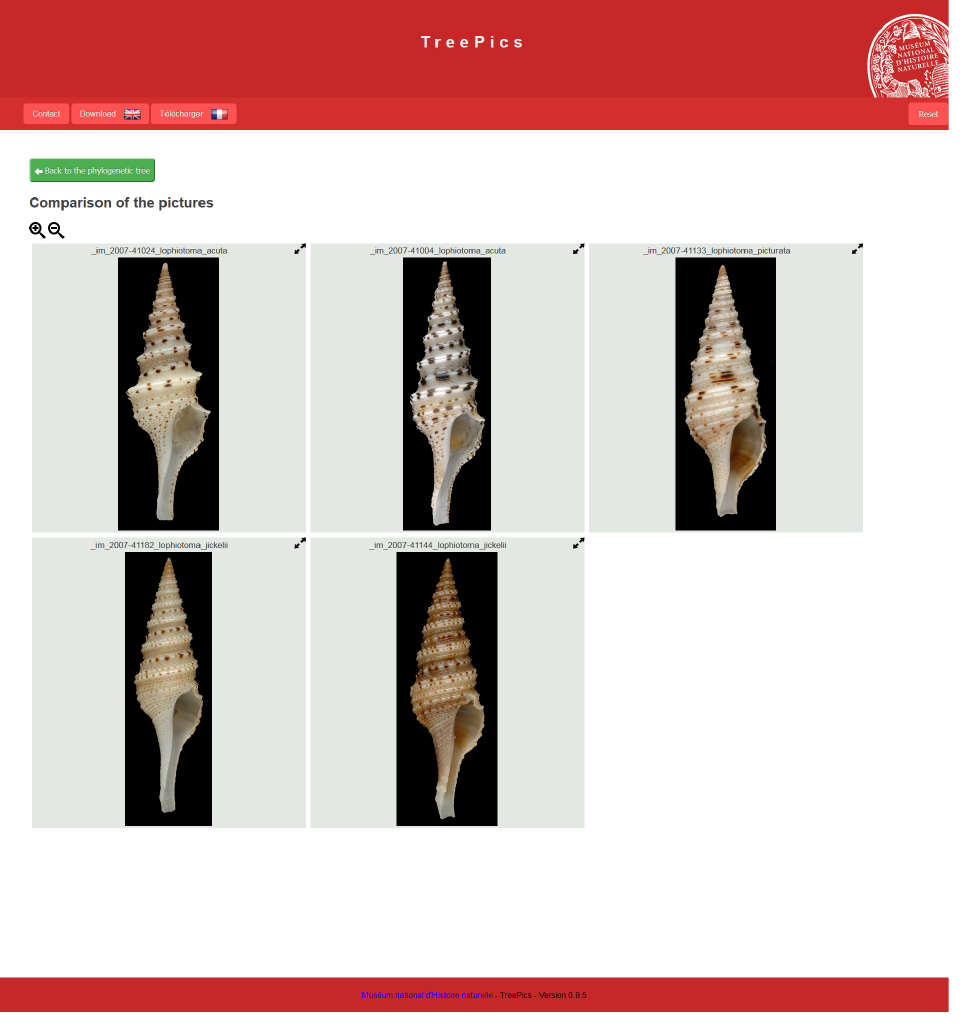
Fig. 2. Screenshot of the page with the specimens selected on the previous